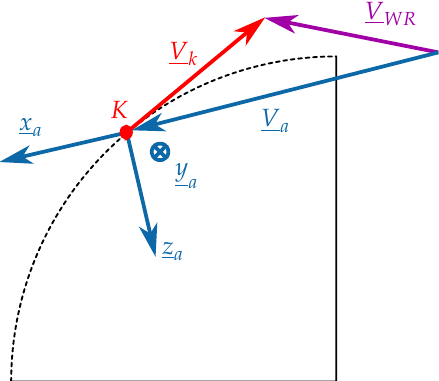
Figure 6. Drawing of the aerodynamic reference frame R a . Kite tethers and kite attachment point are not necessarily contained in the plane of the